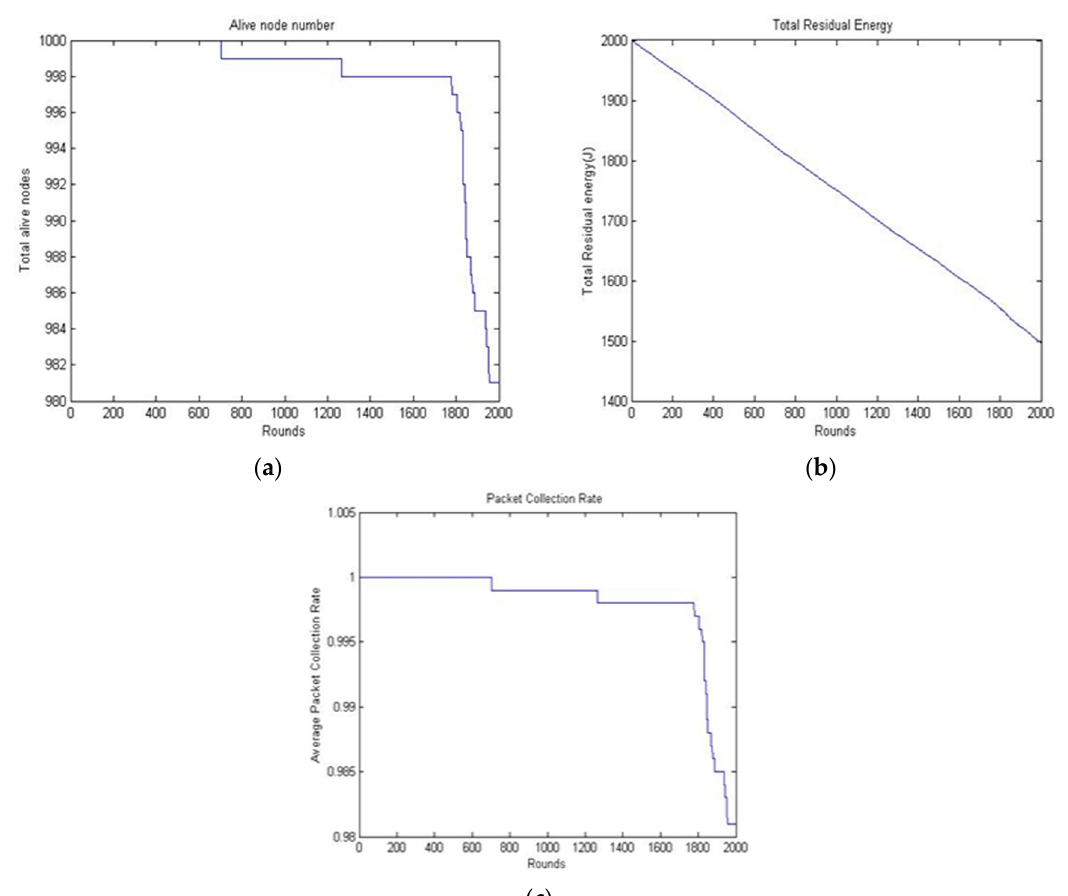
Figure 4. Behavioral analysis of RSC: ( a ) the number of live nodes; ( b ) the residual power level of RSC; and ( c ) the packet received ratio of RSC. and ( c ) the packet received ratio of